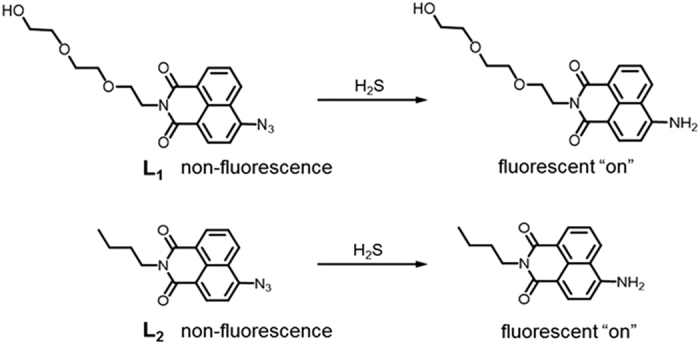
L1 and L2 as fluorescent probes for hydrogen
sulfide.